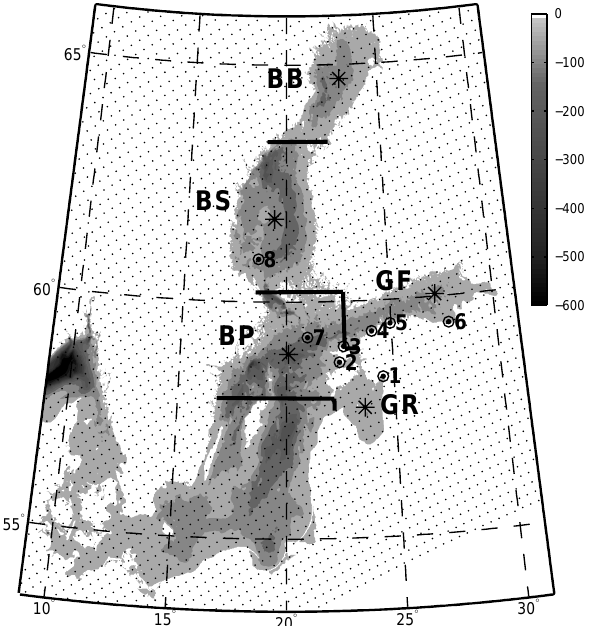
Fig. 1. Bottom topography of the Baltic Sea (in m). Small black dots show the SIDADS-data grid. Thick lines mark the boundaries of the five sub-regions analyzed in the paper (BB: Bothnian Bay, BS: Bothnian Sea, BP: Northern Baltic Proper, GF: Gulf of Finland, GR: Gulf of Riga); asterisks denote the location of sites for which time series of the meteorological data representative of these regions were analyzed. The locations of the measurement stations used for model evaluation are shown with numbered, circled dots. See text for a detailed